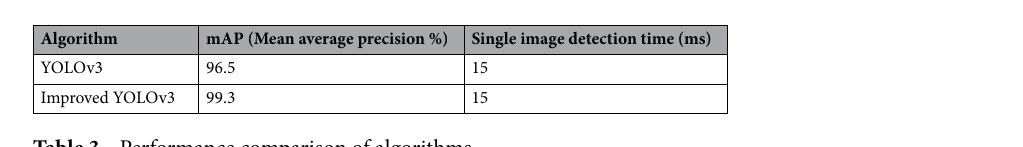
Table 3. Performance comparison of algorithms.